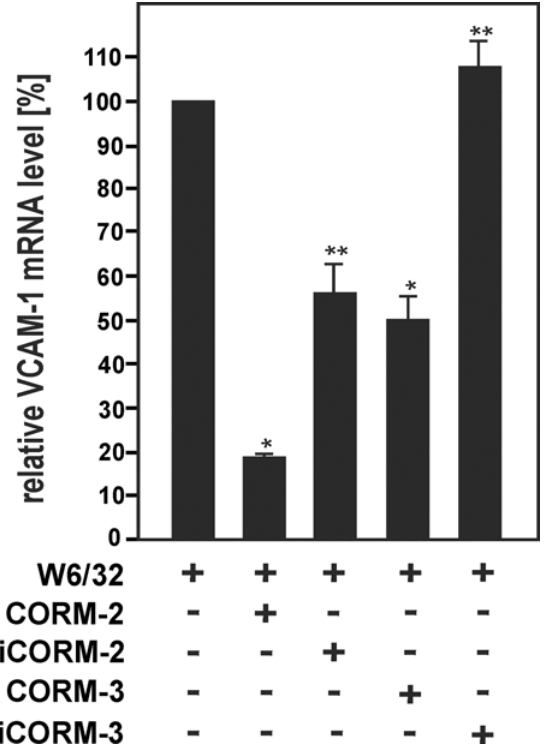
Fig 4. CORMs decrease HLA class I Ab-induced VCAM-1 expression in HUVECs. Confluent HUVECs were incubated with W6/32 or isotype control (10 μ g/ml) for 18 h in the presence or absence of CORM-2 (25 μ M), iCORM-2 (25 μ M), CORM-3 (75 μ M) or iCORM-3 (75 μ M), as indicated. Cells were lysed and subjected to RT-PCR analysis. The fold induction of mRNA levels is indicated. Data are represented as mean ± SEM from three independent experiments. * p (cid:3) 0.05, significant differences CORM-2/3 versus W6/ 32; ** p (cid:3) 0.05, iCORM-2/3 versus